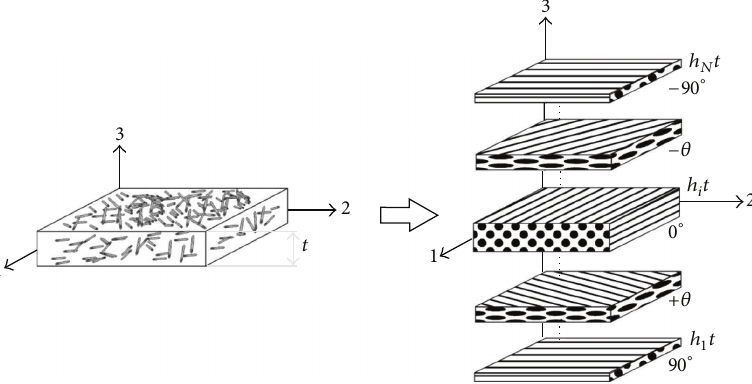
Figure 4: Schematic illustration of a laminate analogy for randomly oriented cellulose fiber composites.